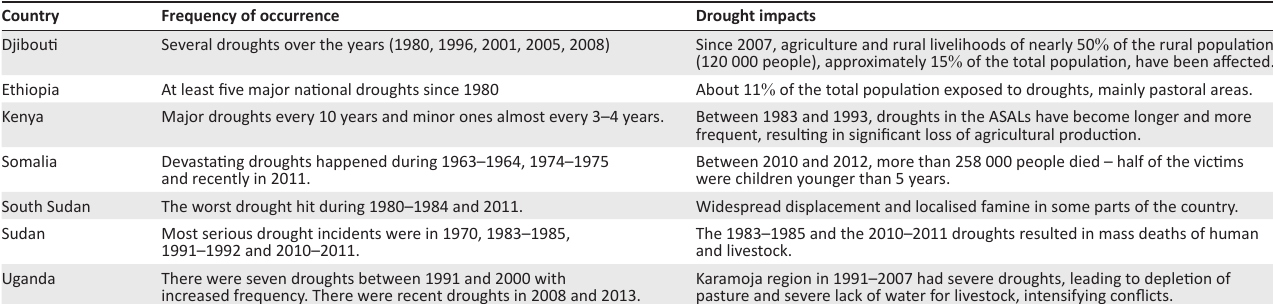
TABLE 3: Drought hazard occurrence and impact of damage.